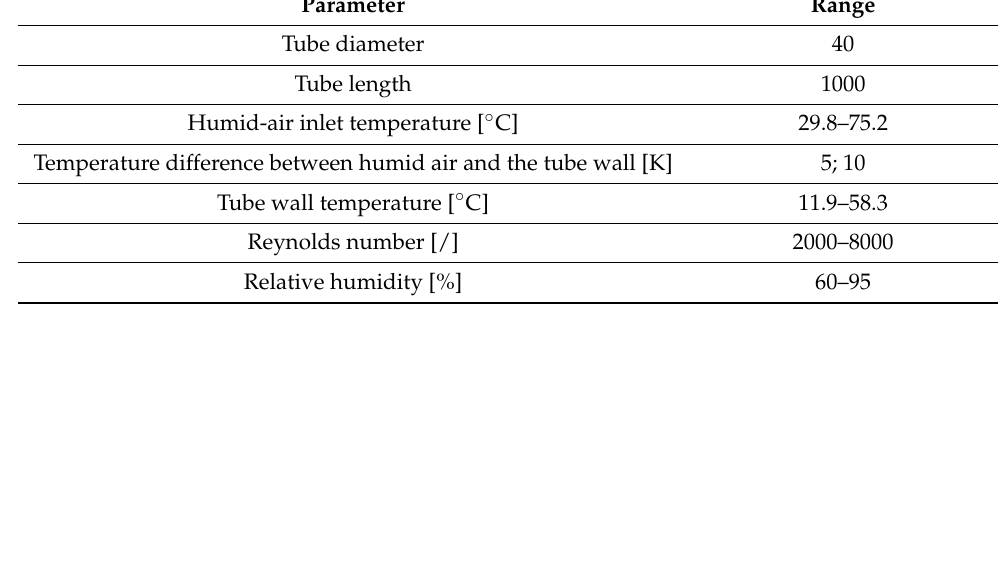
Table A3. Condensation mass fluxes obtained from our experiments and from theoretical calculations with the modified correlation from Fouda et al. [13] ( m (cid:48)(cid:48) avg , Fouda ) and the newly developed correlation ( m (cid:48)(cid:48) temperature of humid air, temperature difference between humid air and the wall, and volumetric flow rate of the humid air for 3-tube row condenser, d = 40 mm, and 7-tube row condenser, d = 15 mm. 3-Tube Row Condenser, d = 40 mm 7-Tube Row Condenser, d = 15 mm